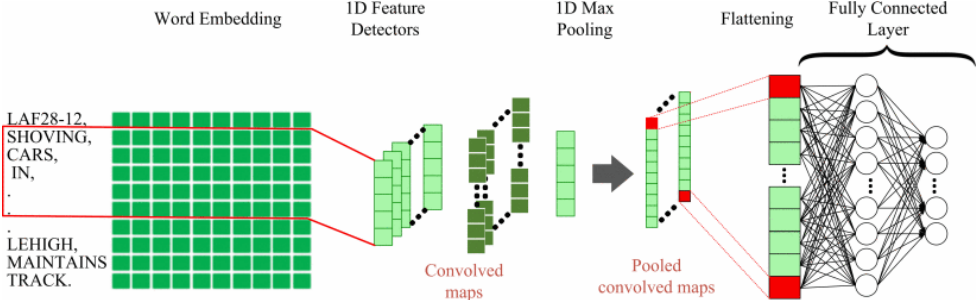
Figure 9. Proposed network structure for managing accident records. Reproduced with permission from IEEE